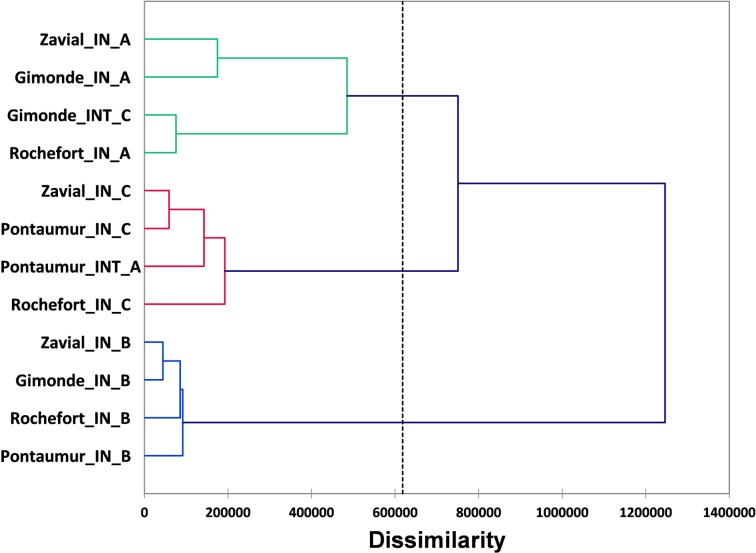
Dendrogram (distance measure: Euclidian; Linkage rule: Ward’s method) resulting of the hierarchical clustering analysis for RH levels measured in hives of the four conservation centers over a complete year for each iButton (A, B, C).